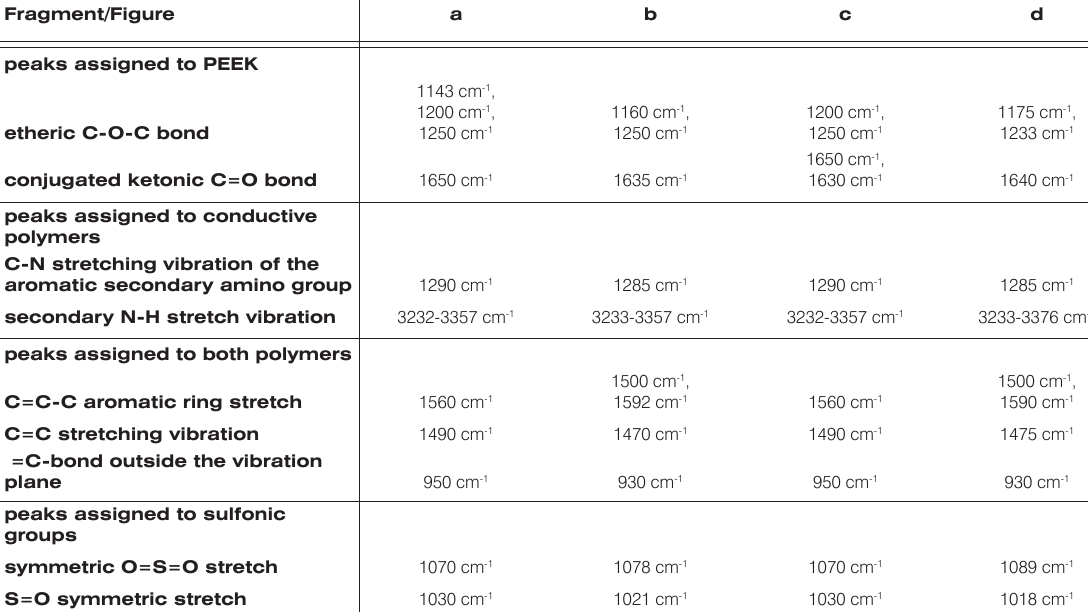
Table 1. The assignments of peaks in the IR spectra.